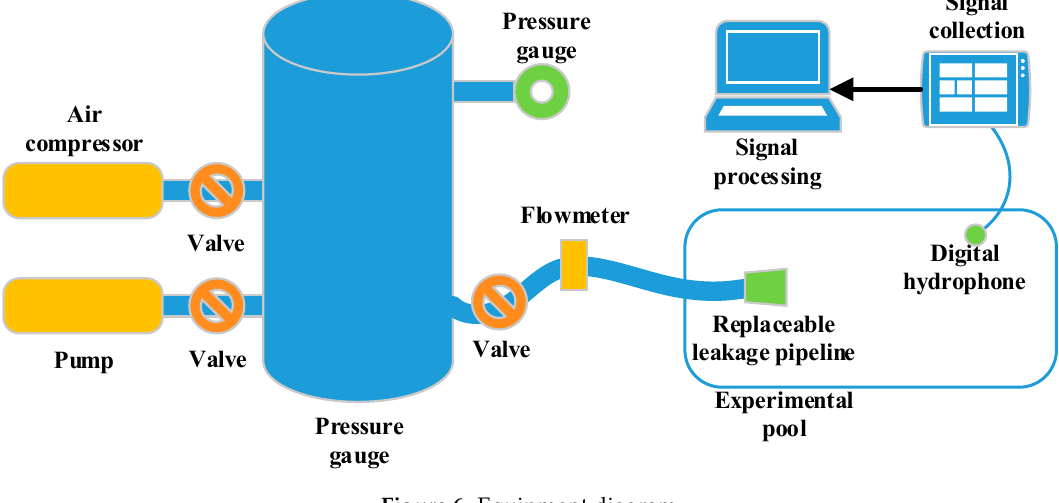
Figure 6. Equipment diagram.